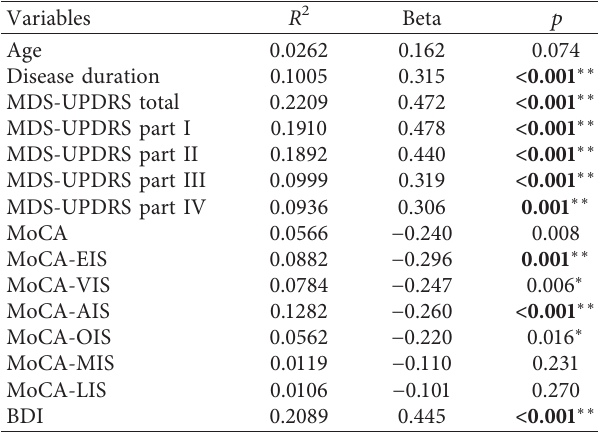
Table 4: Linear regression analysis of factors influencing caregiver burden (PDCB), n � 78.